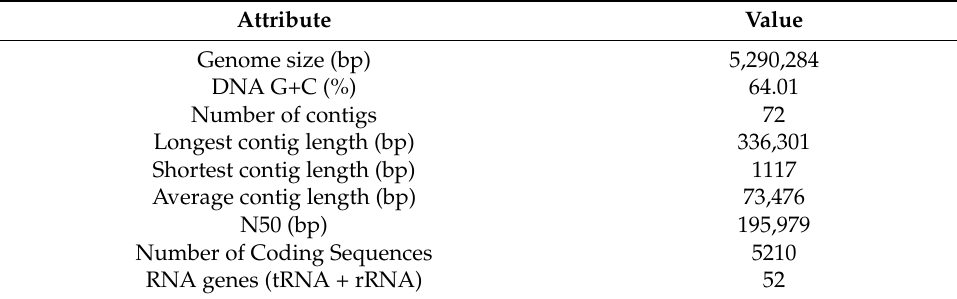
Table 1. General features of the genome of Rhodococcus sp. I2R.